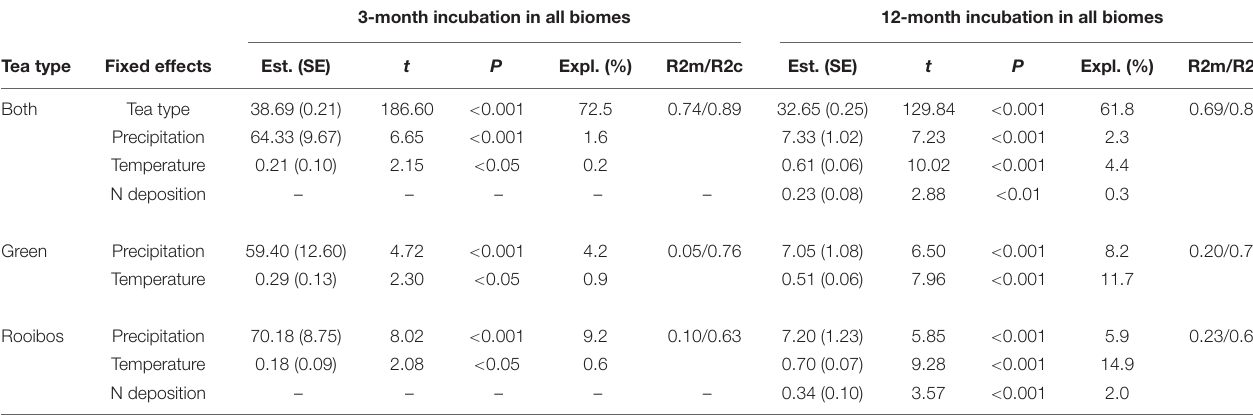
FIGURE 2 | Mass loss of tea litters (%); Green tea (blue) and Rooibos tea (orange) after the field incubation of 3 (A) and 12 months (B) across biomes. Blue and orange circles show the means, and the bars are the standard errors based on the total number of observations. Uppercase and lowercase letters denote significant differences among biomes for Green and Rooibos tea, respectively, based on a Kruskal–Wallis test ( p < 0.05). The order of biomes follows the order of mean monthly precipitation (mm month - 1 ) for (A) and mean annual precipitation (mm year - 1 ) for (B) . In case that the number of sites is < 3 sites at each biome, then the data were not included in statistical analysis (i.e., Arid-temperate). TABLE 3 | The effects of climatic factors and N deposition on the mass loss of Green tea and Rooibos tea after 3 and 12 months of incubation in all